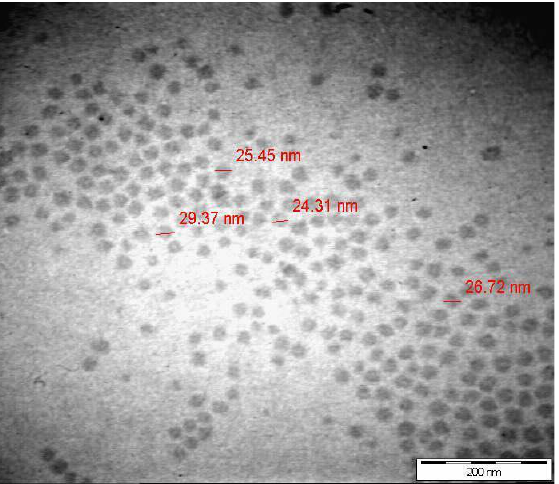
Figure 2. TEM visualization and analysis of methylene blue (MB) encapsulated within silica nanoparticles (SiNPs).